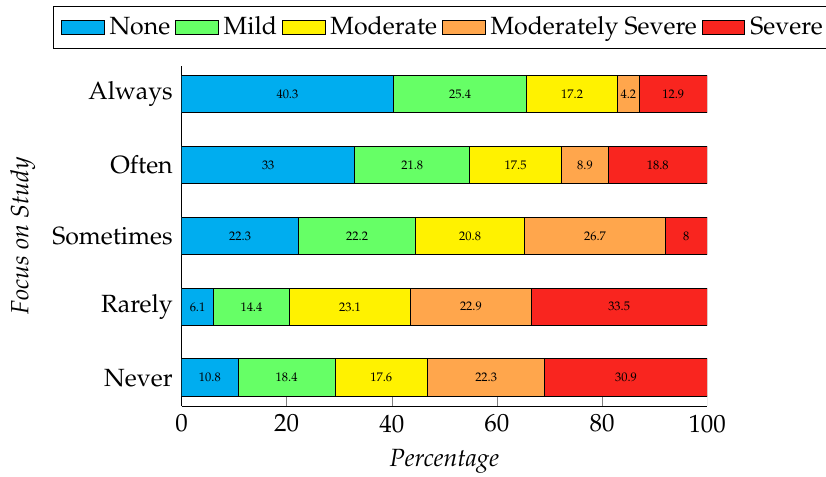
Figure 1. Relation between students’ focus on study and their level of depression.